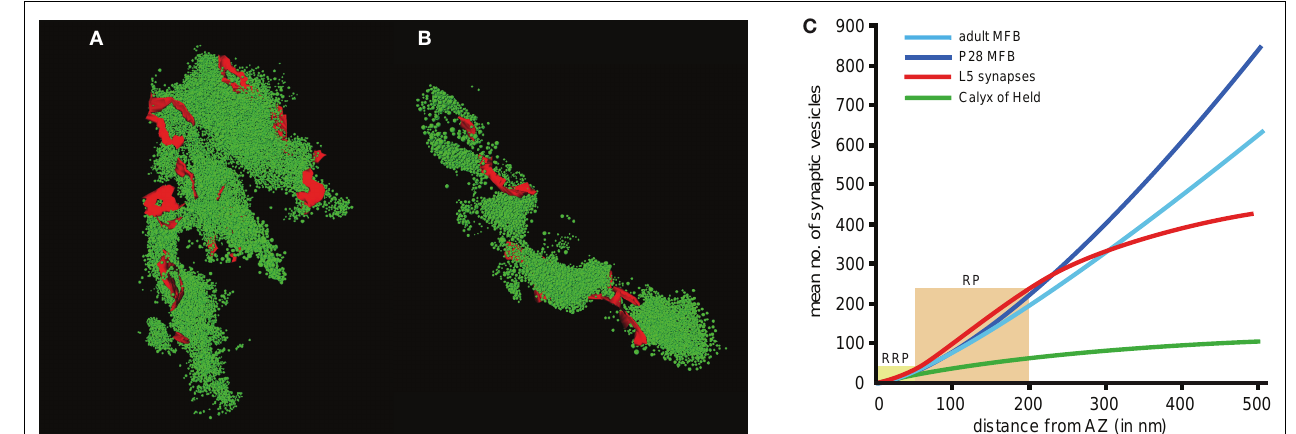
layer 5 input synapses (red line). The light yellow boxes indicate the borders between the RRP, the RP and the reserve pool of synaptic vesicles. Note, that the slope of the curves is markedly higher in the MFBs and layer 5 input synapses when compared with the calyx of Held synapse, even though the spacing between individual AZs is comparable at these